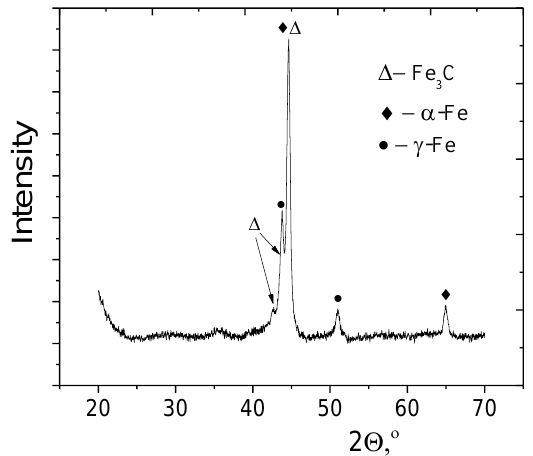
Figure 1. Representative TEM images of Fe@C particles: ( a ) overview and ( b ) close-up view.